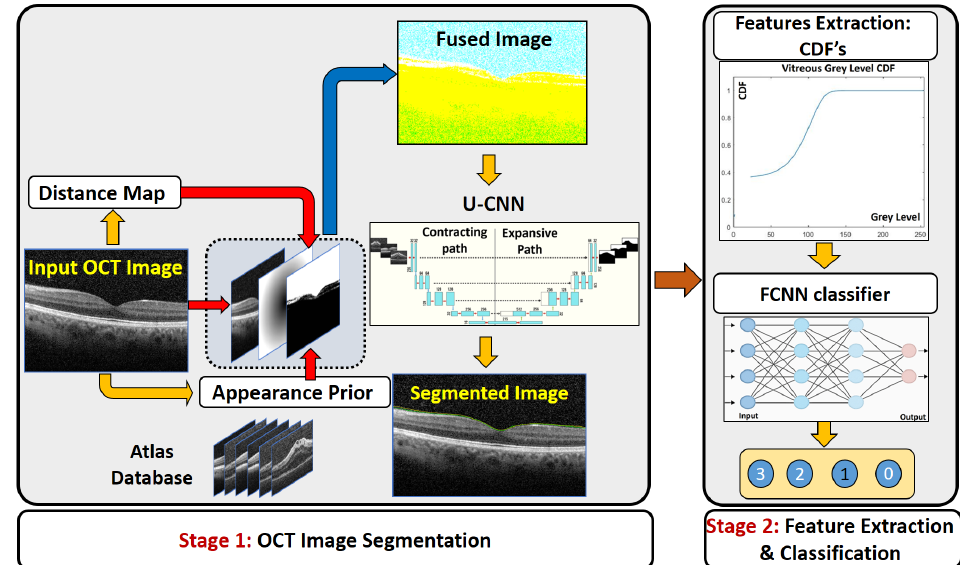
Figure 1. Illustration of the proposed CAD. The first stage is the segmentation stage depending on fused image and U-CNN. The second stage is the classifier to predict the grade of vitreous inflammation